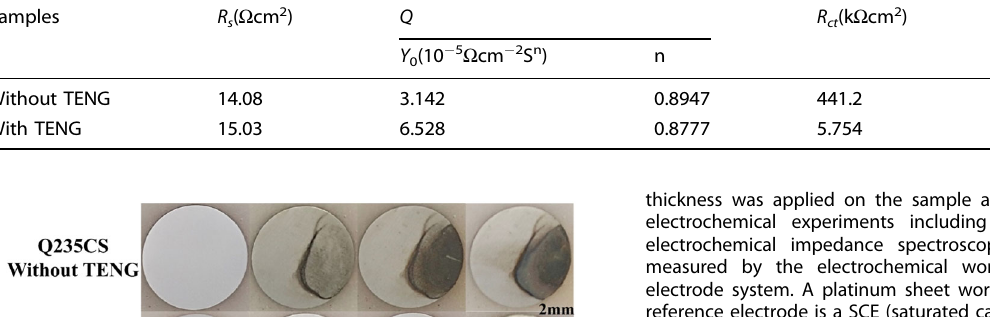
Table 2. Electrochemical impedance parameters for 304SS with and without impressed current cathodic protection powered by the S-TENG in 3.5 wt % NaCl solution.